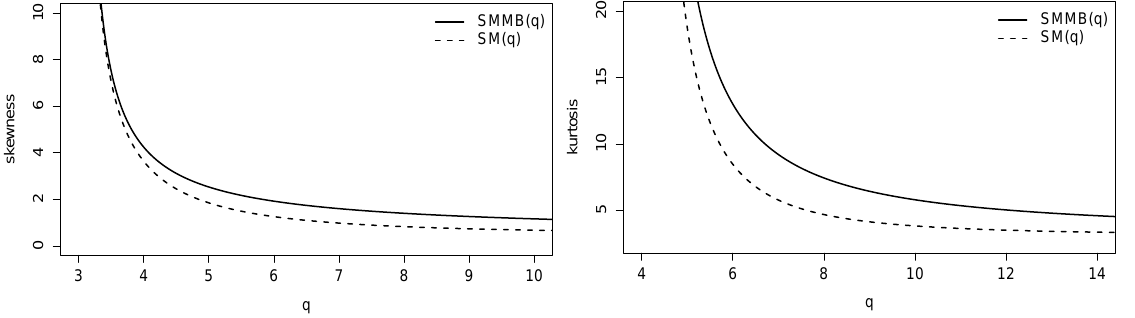
Figure 4. ( Left panel ): skewness coefficient. ( Right panel ): kurtosis coefficient; for the SMMB and SMB